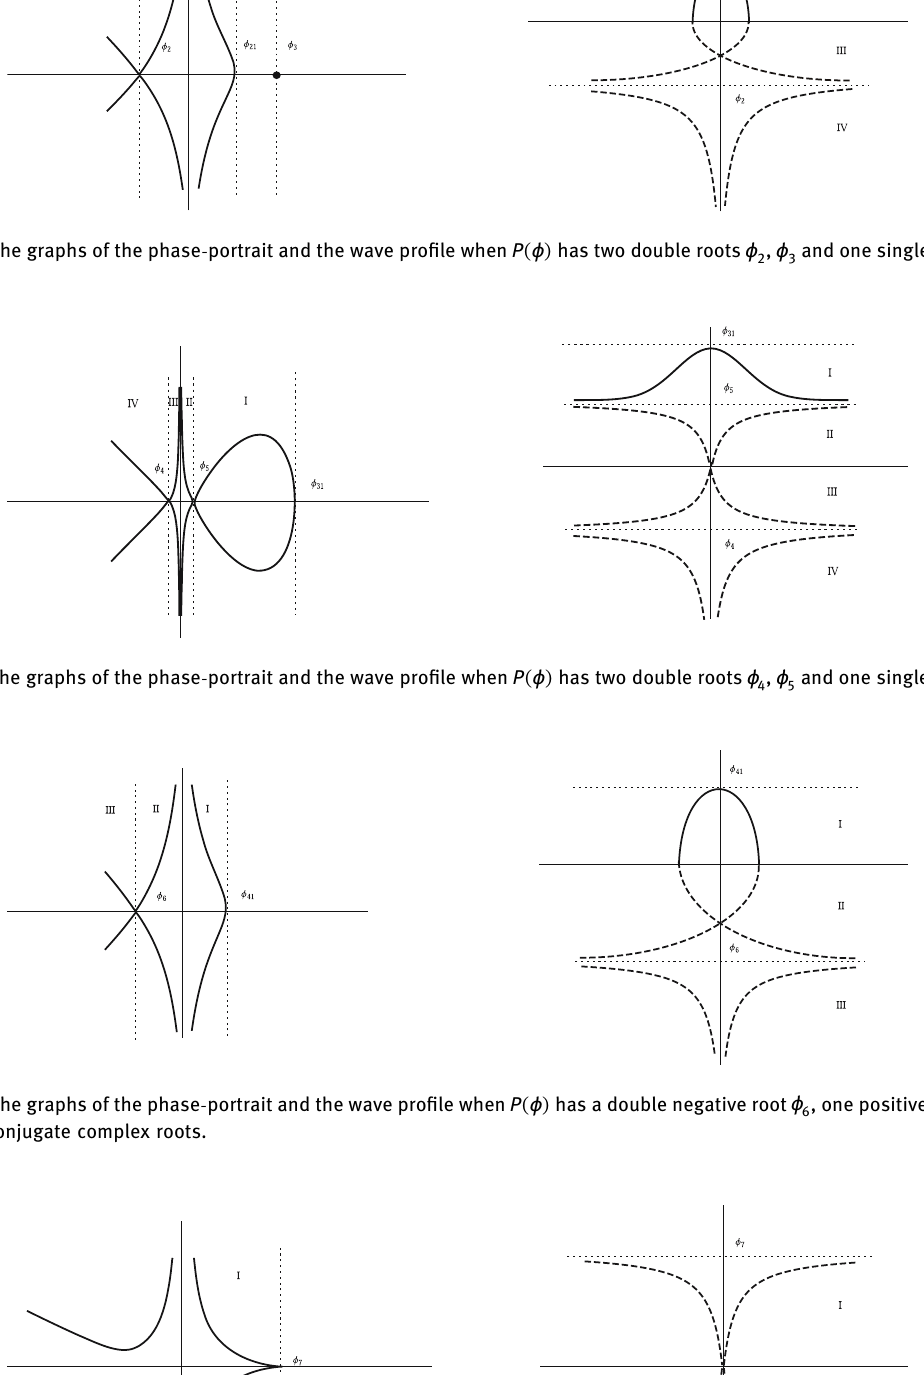
Figure 7: The graphs of the phase - portrait and the wave pro fi le when ( ) P ϕ has a triple positive root ϕ complex